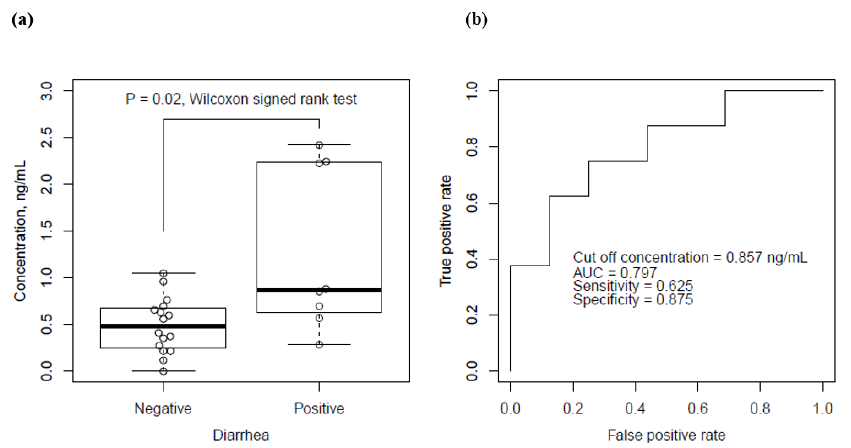
Figure 3. Association of serum bortezomib concentration with the emergence of diarrhea. ( a ) Boxplots of serum bortezomib concentration in patients without or with diarrhea; ( b ) receiver operation characteristic (ROC) analysis of serum bortezomib concentration for the emergence of diarrhea.